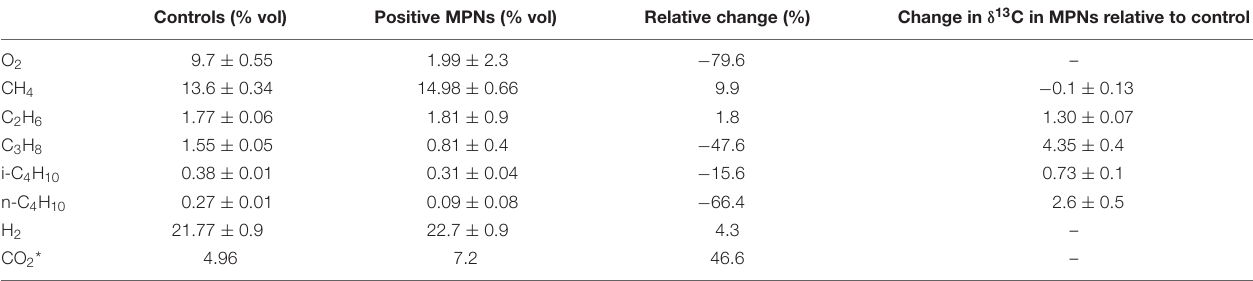
TABLE 4 | Headspace gas analysis of aerobic alkane oxidizing MPNs enrichments.